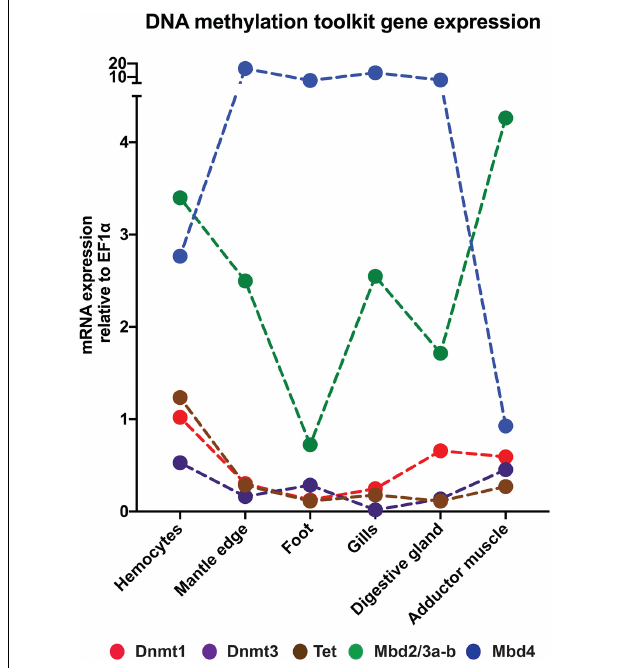
FIGURE 7 | Expression profiles of the Dnmt1, Dnmt3, Tet, Mbd2/3a-b, and Mbd4 in different Mytilus galloprovincialis adult tissues.